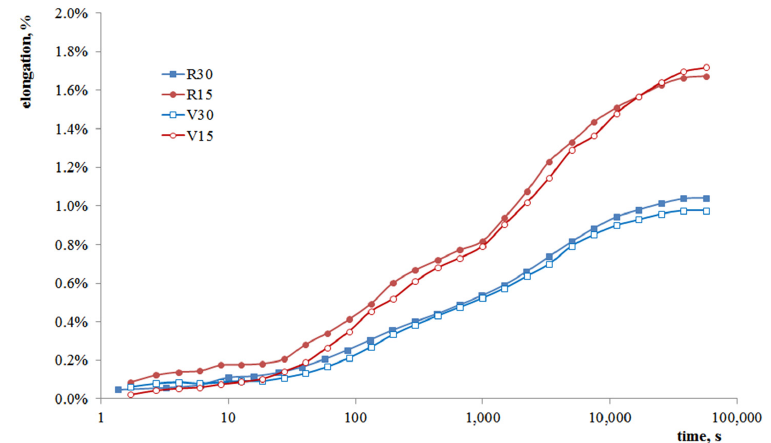
Figure 4. Creep curves of the composites at 60 °C and 1.5 MPa load (15% and 30% filled composites: V15 and V30; 15% and 30% filled composites prepared after repeated recycling of the polymer matrix: R15 and R30).